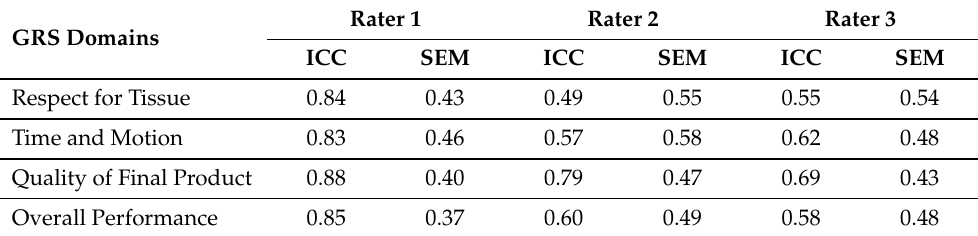
Table 4. Test-retest performance of the human raters on the forty repeated trials. Although the raters performance varies, they all show moderate to good